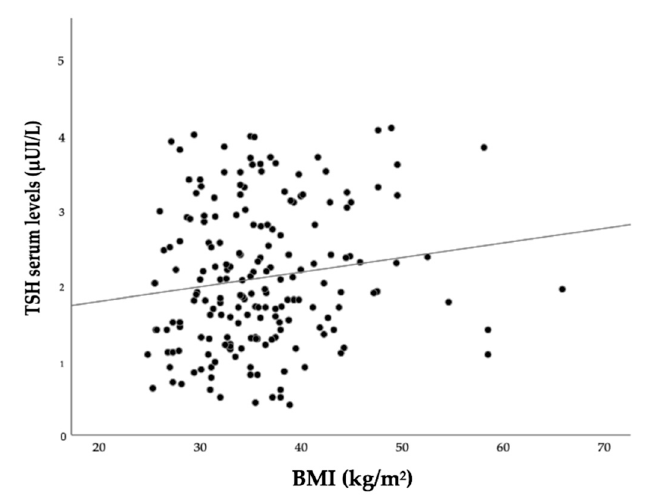
Figure 1. Spearman’s correlation between TSH and BMI in ATAs-positive female patients.